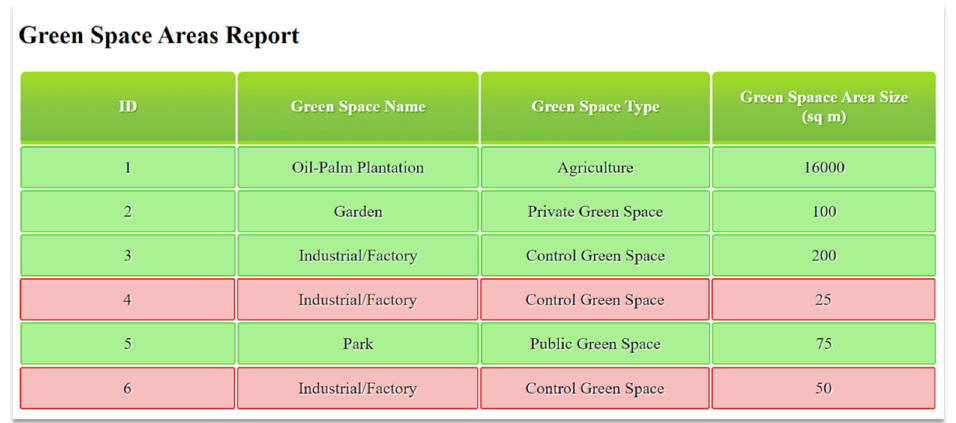
Figure 10. A green space table, listing ID, name, type, and size of selected green space areas. Green and red background indicate whether or not they conform to the regulations, respectively.